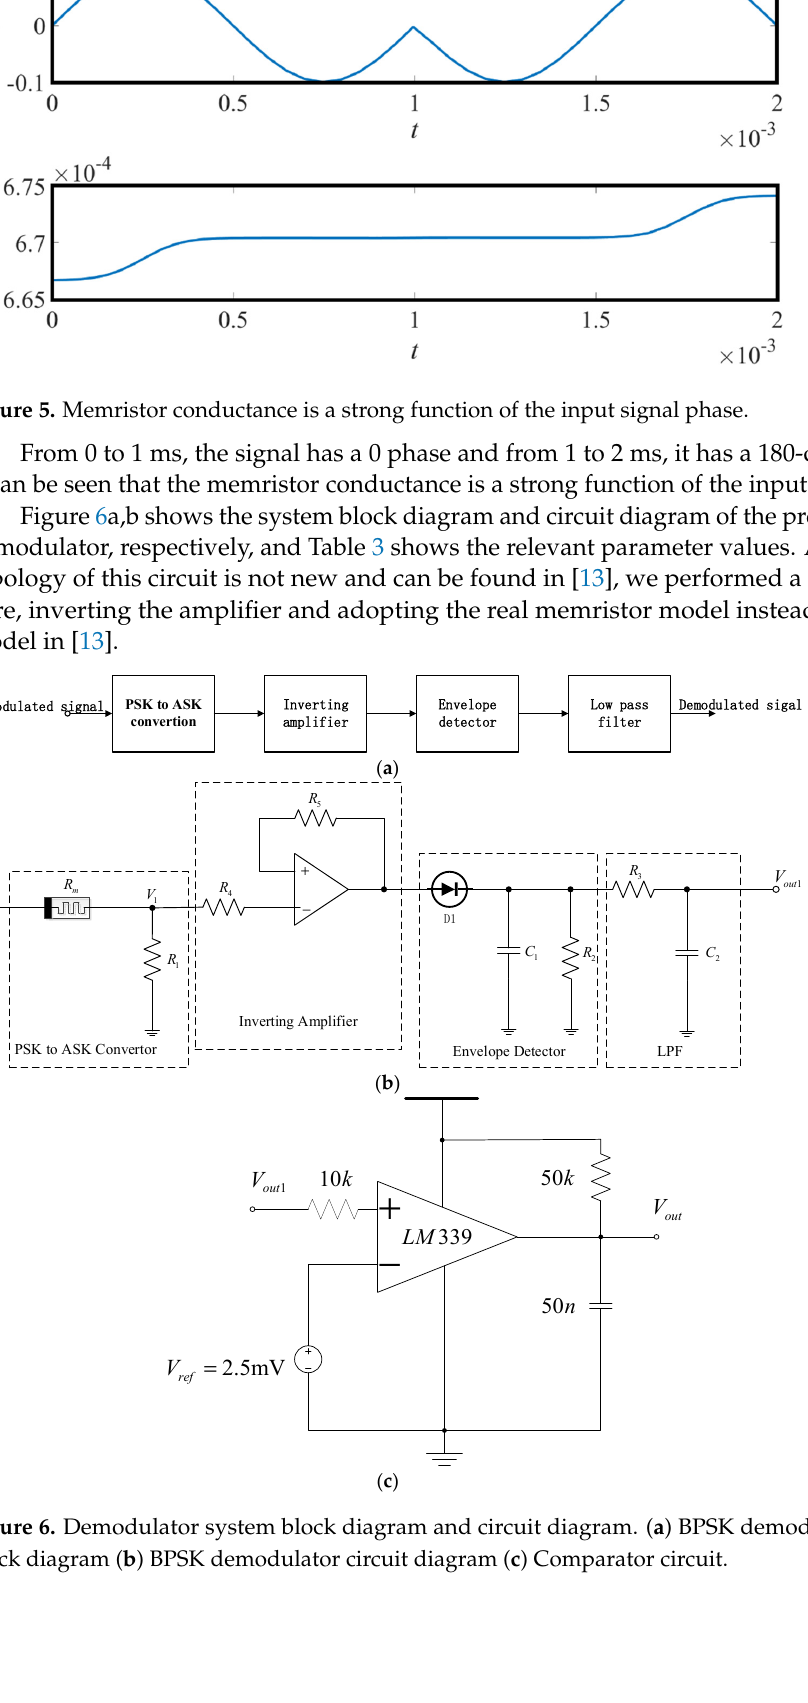
Figure 6. Demodulator system block diagram and circuit diagram. ( a ) BPSK demodulator system block diagram ( b ) BPSK demodulator circuit diagram ( c ) Comparator circuit. Table 3. List of parameters of Figure 6. Parameter